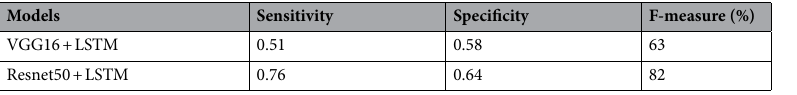
Table 4. Performance of combined CNN with RNN trained on images and tested on sequential images.